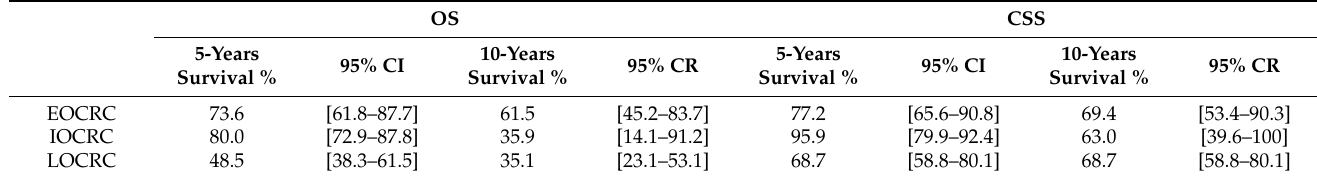
Table 4. Survival analysis according to the age of